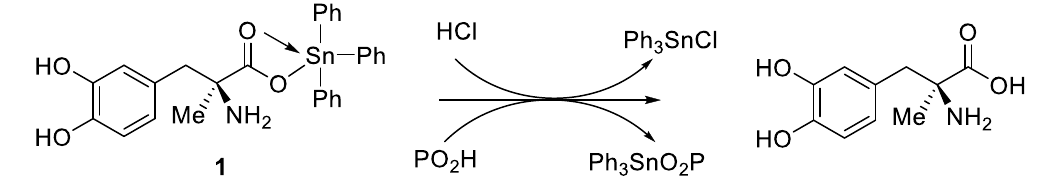
Figure 11. AFM images of the irradiated PVC films.